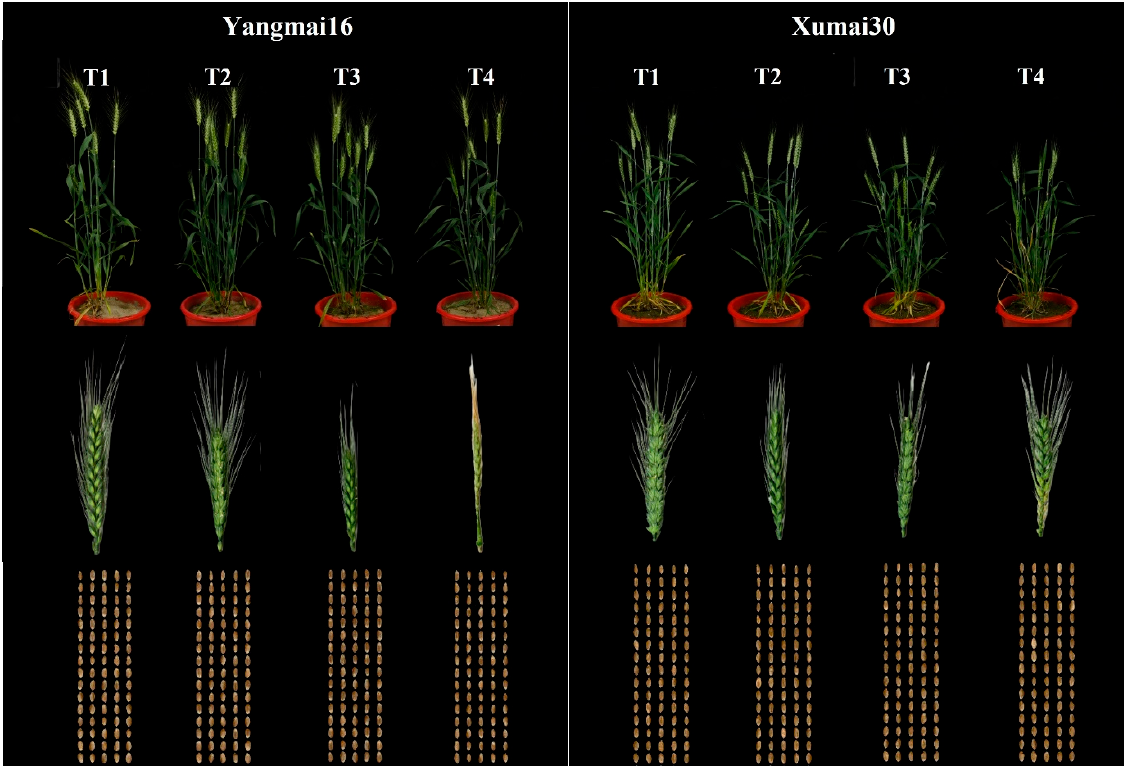
Figure 1. The plants, spikes, and grains of Yangmai16 and Xumai30 under different low ‐ tempera ‐ ture treatments. Table 1. Summary of the